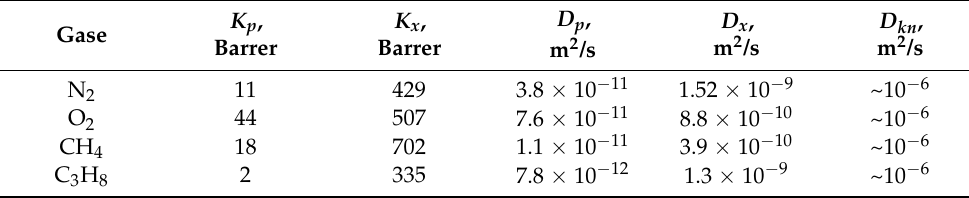
Table 2. Experimental and calculated gas permeability coefficients and Knudsen diffusion coefficient for the studied